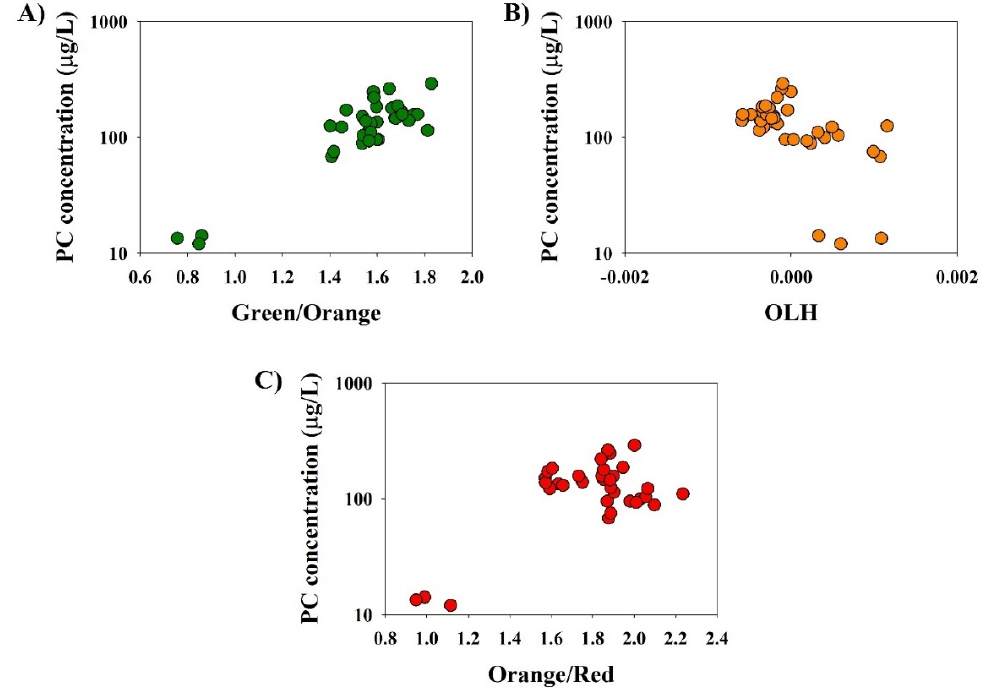
Figure 5. Correlation between PC concentration and remote sensing parameters for the samples with PC:chl- a ratios higher than 1.5 ( n = 35). ( A ) for the green:orange ratio; ( B ) for the OLH; and ( C ) for the orange:red ratio. Table 2. Best fit for each remote sensing model for each dataset.